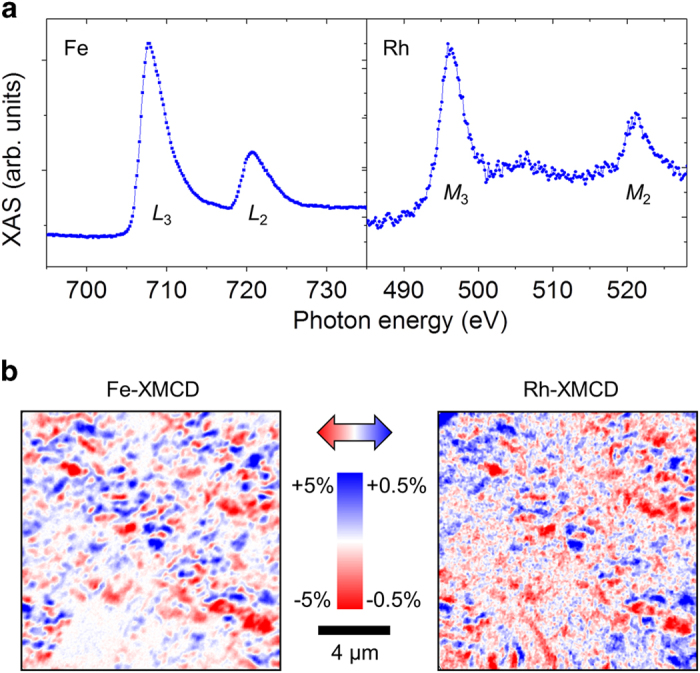
X-ray absorption and XMCD in XPEEM.(a) X-ray absorption spectra of FeRh with horizontal linear polarization averaged over a 20-μm field of view, showing Fe L3,2 and Rh M3,2 peaks. (b) XMCD images of the same area at Fe L3 and Rh M3 edges. Blue (red) areas have a magnetization component parallel (antiparallel) to the incoming X-rays.